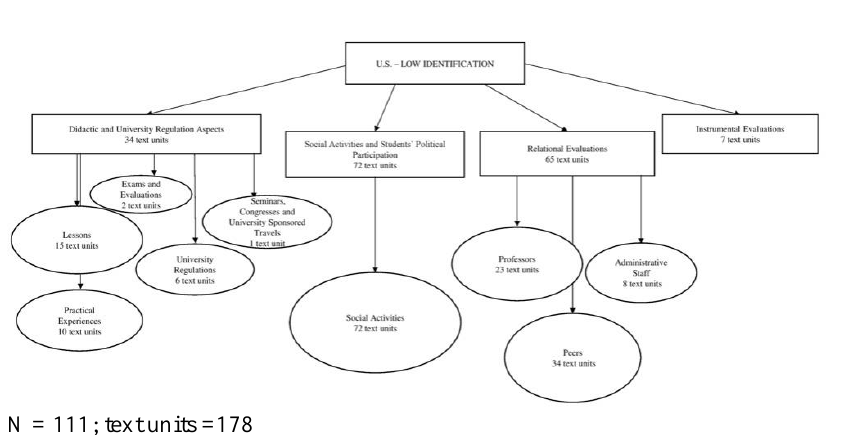
N = 111; text units =178